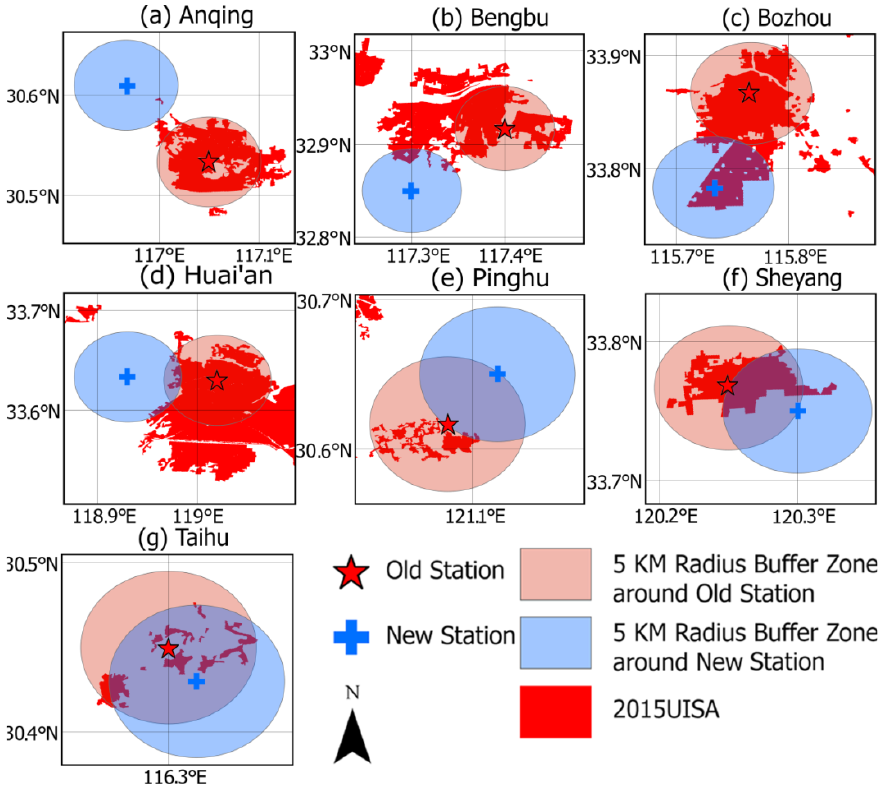
Figure 8. Maps showing the 5 km radius buffer zone around the old and new stations and the level of the built-up area in the surrounding environment for ( a ) Anqing (AQ), ( b ) Bengbu (BB), ( c ) Bozhou (BZ), ( d ) Huai’an (HA), ( e ) Pinghu (PH), ( f ) Sheyang (SY) and ( g ) Taihu (TH) stations in Figure 1. The built-up area and anthropogenic heat environment around the stations improved and their linear changes were consistent after relocation (Figure 9). However, the difference in the PBA in the buffer zone between the stations was relatively significant, whereas the changes in the AHF were consistent. The PBA after relocation averaged 43.2% of that of the old station, with a minimum of 0.5% and a maximum of 114.1%. For comparison, the average AHF of the old station was 57.0%, the minimum was 41.5% and the maximum was 76.5%. The AHF was mainly affected by a combination of many urban-driven factors.